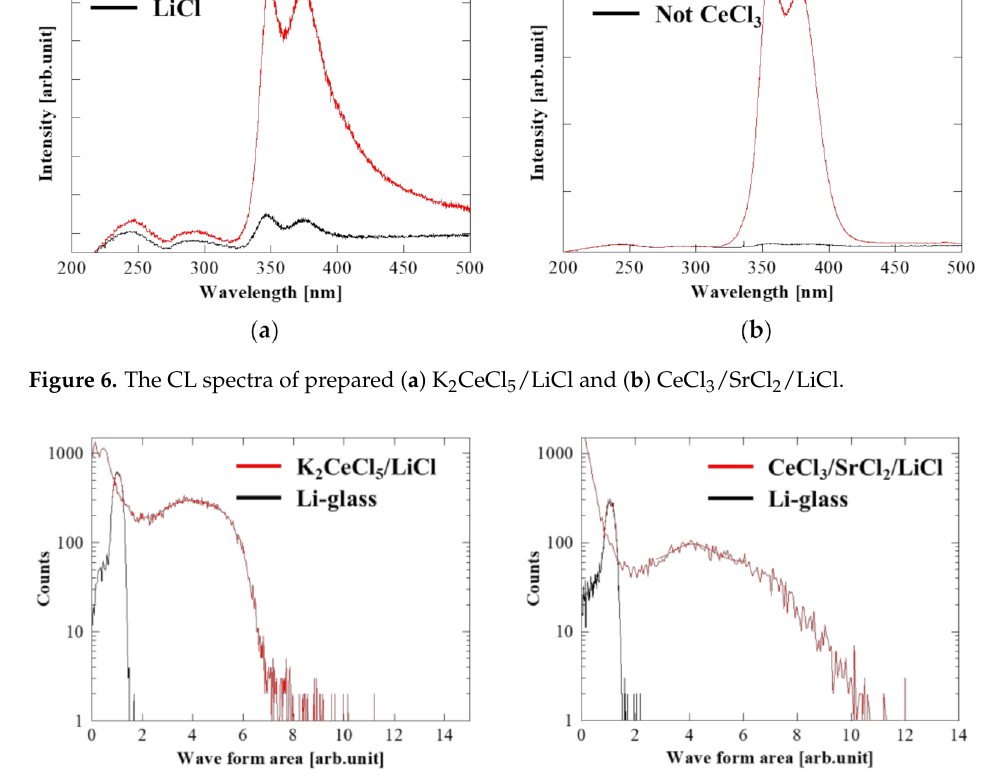
Figure 7. Pulse-height spectra of prepared ( a ) K 2 CeCl 5 /LiCl and ( b ) CeCl 3 /SrCl 2 /LiCl under 252 Cf